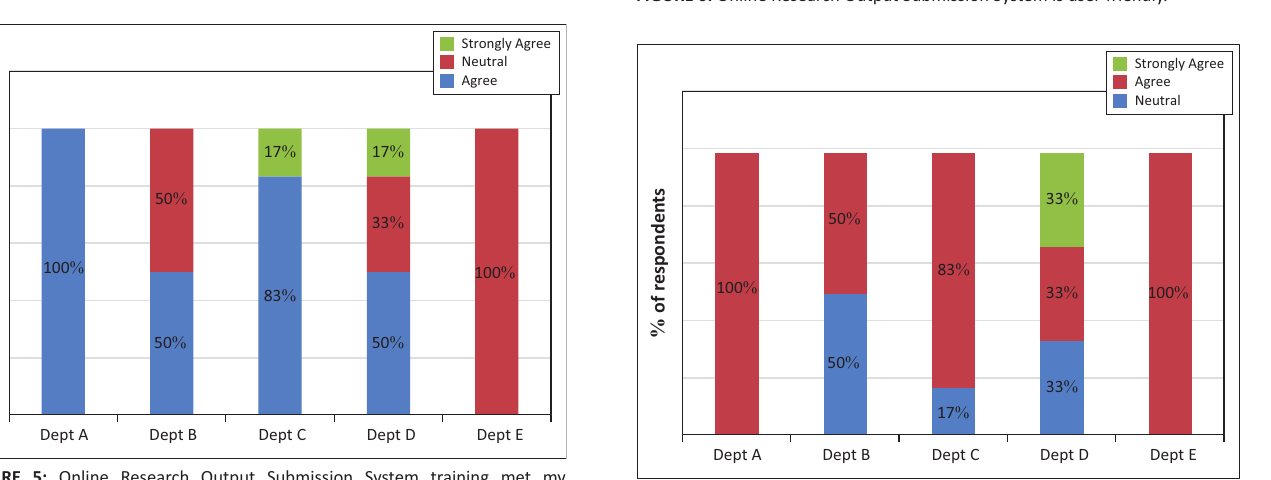
FIGURE 6: Online Research Output Submission System is user-friendly.